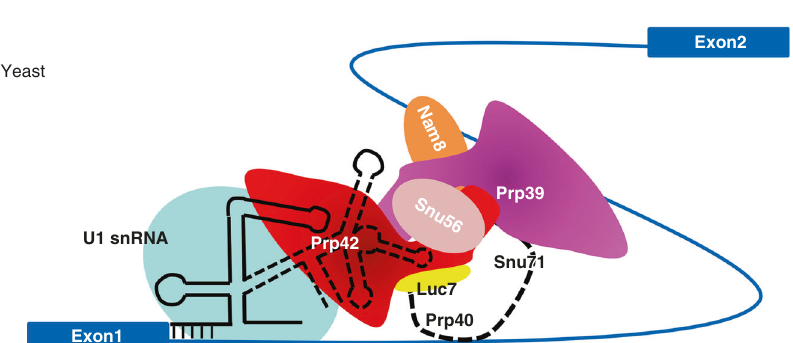
Fig. 6 Yeast U1 snRNP serves as a model for the association of alternative splicing factors with human U1 snRNP. This model is supported by our observation that human PrpF39 forms a homodimer that directly interacts with U1C-CTD, mirroring the interaction between the Prp42/Prp39 paralogs and U1C-CTD in yeast U1. In human cells, an alternative splicing factor such as TIA1, Luc7L, PrpF40, and RBM25 (and possibly a functional homolog of Snu56) binds pre-mRNA through their RNA-binding domains and likely interact with the U1 snRNP in the same fashion as in the yeast U1 snRNP to facilitate the binding between U1 snRNA and 5 ʹ -ss. Although some of these alternative splicing factors can directly interact with core components of U1 snRNP, PrpF39 likely plays a major role in facilitating the association between these factors and the core U1 snRNP, possibly through its extensive interactions with these factors, analogous to those observed in the yeast U1 snRNP structure. PrpF39 may also serve as an alternative splicing factor on its own through possible interactions between its N-terminal TPR domain and